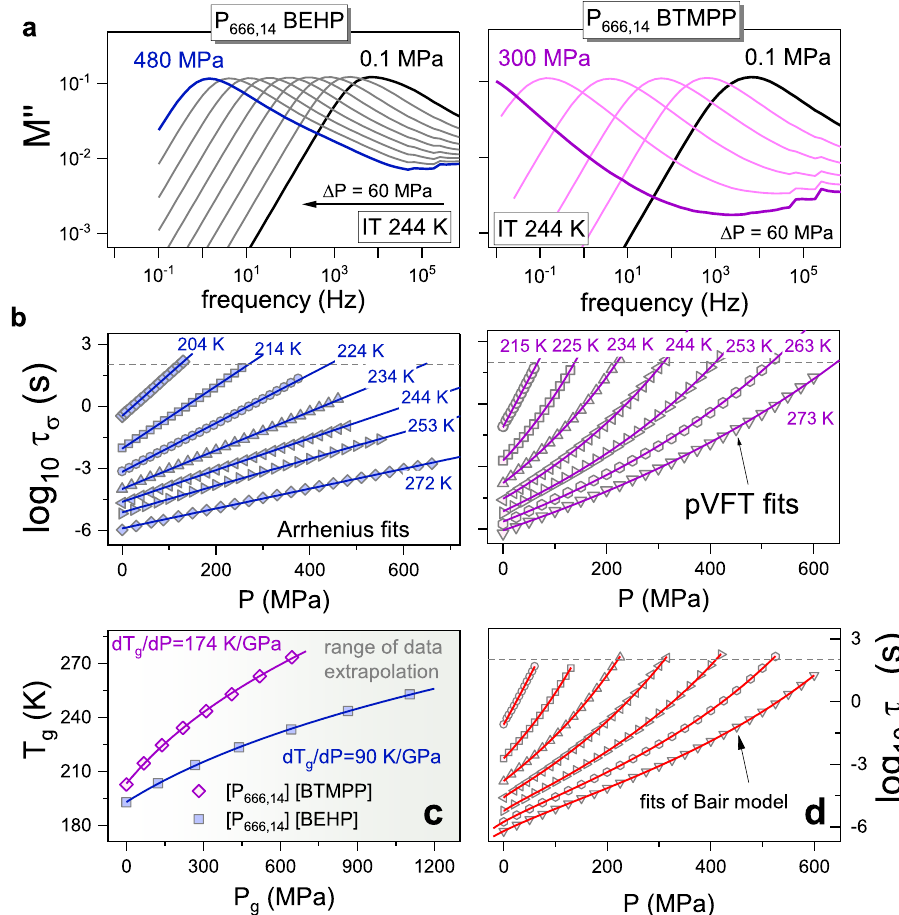
Figure 5. ( a ) The imaginary part of the dielectric loss modulus M ’’ versus frequency registered during the compression of [P 666,14 ][BEHP] and [P 666,14 ][BTMPP] at T = 244 K. ( b ) Pressure dependence of the conductivity relaxation times τ σ measured at different isothermal conditions for [P 666,14 ][BEHP] and [P 666,14 ][BTMPP]. The solid lines denote the corresponding fits, i.e., Arrhenius fit for [P 666,14 ][BEHP] and pVTF fit for [P 666,14 ] [BTMPP]. ( c ) Pressure dependence of the glass transition temperature T g for studied ILs. The solid lines are fits of the Andersson-Andersson equation to the experimental data. ( d ) Pressure dependence of log 10 τ σ ( P ) of [P 666,14 ][BTMPP] for the same isotherms. The solid lines represent the fits with the hybrid model (Eq.